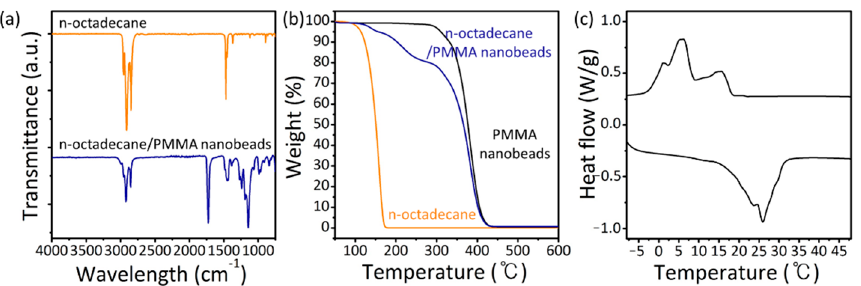
Figure 3. ( a ) FT-IR spectra of n-octadecane and n-octadecane/PMMA nanobeads. ( b ) Thermogravi- metric analysis (TGA) of n-octadecane, PMMA nanobeads, and n-octadecane/PMMA nanobeads. ( c ) Differential scanning calorimetry (DSC) curves of n-octadecane/PMMA nanobeads.